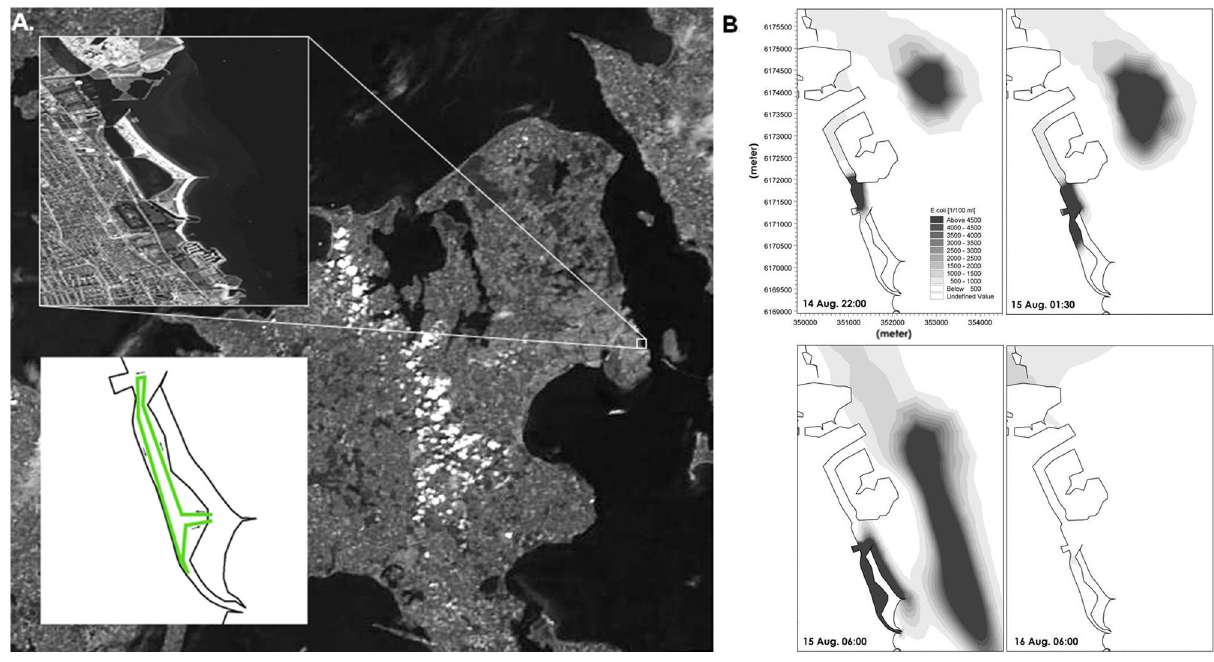
Figure 1. The modelled concentrations of E. coli in the coastal area east of Copenhagen, August 2010. Panel A shows a satellite photo of the Danish island of Zealand including the Copenhagen area, where the swim course took place in a coastal lagoon. The swim route is shown in green. Panel B shows the modelled concentrations of E. coli in the lagoon and surrounding area in August 2010 at: a) 10:00 p.m. 14 Aug, b) 1:30 a.m. 15 Aug, c) 6:00 a.m. 15 Aug (shortly before the competition began), and at d) 6:00 a.m. 16 Aug. CSO124 indicate the sewage overflow discharge point and WWTP the bypasses from the waste water treatment plant. doi: